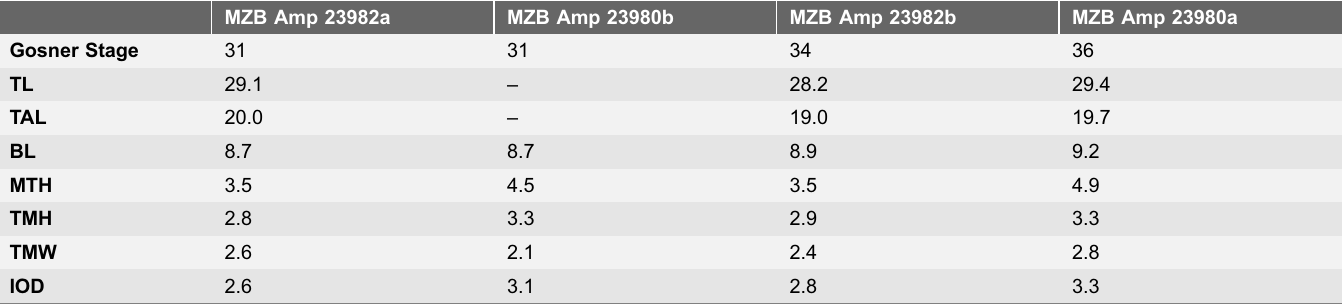
Table 1. Gosner (1960) stage and measurements (mm) of four Limnonectes larvaepartus tadpoles from Nantu.